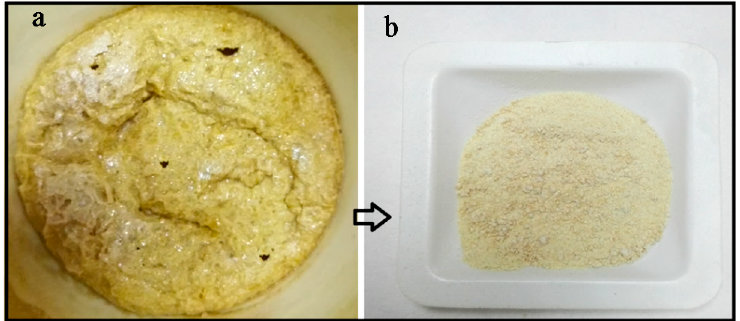
Figure 10. Photograph formation of ( a ) foam and prepared ( b ) ZnO-NPs.